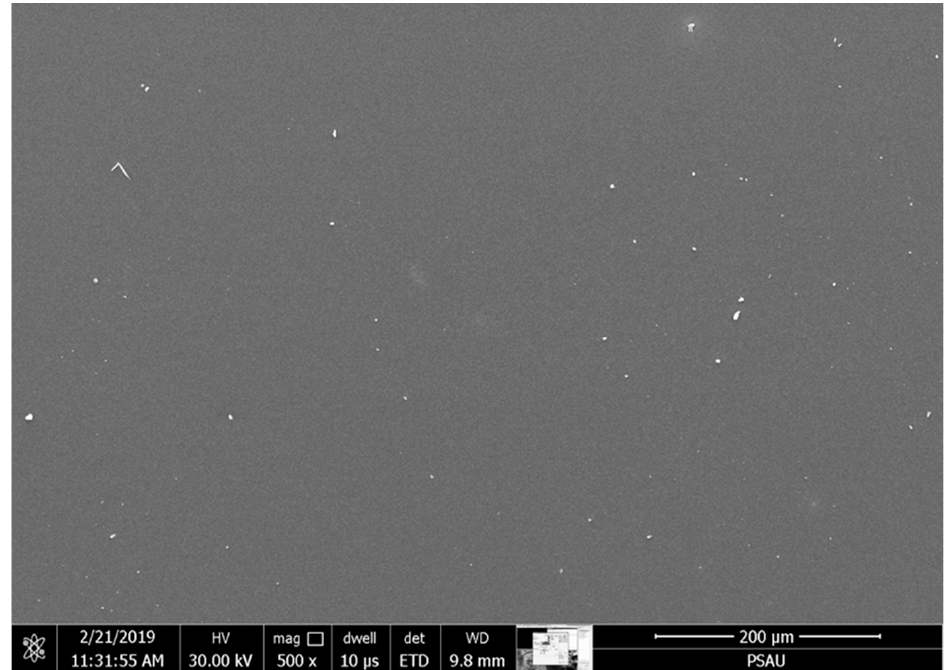
Figure 7. SEM image of ZnO film coated at 3500 rpm.